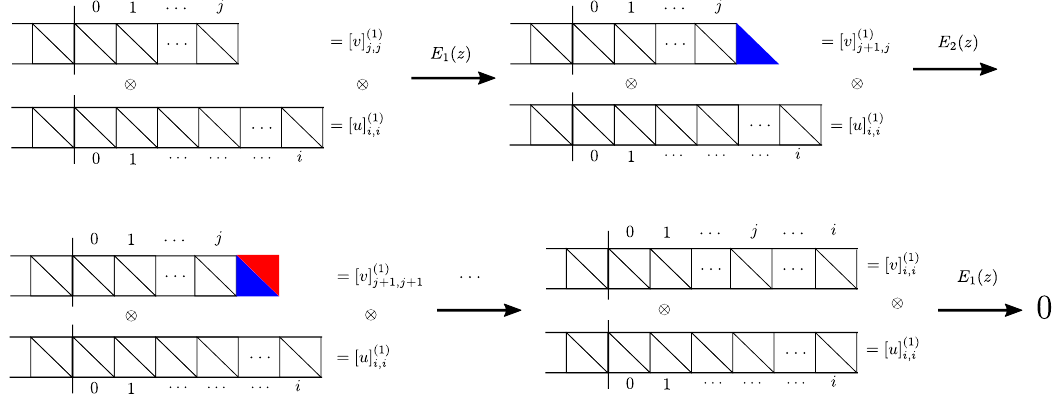
Figure 21. Sequence of actions of E 1 ( z ) and E 2 ( z ) on the second tensor components of [ u ] (1) and [ u ] (1) ⊗ [ v ] (1) i,i j,j − 1